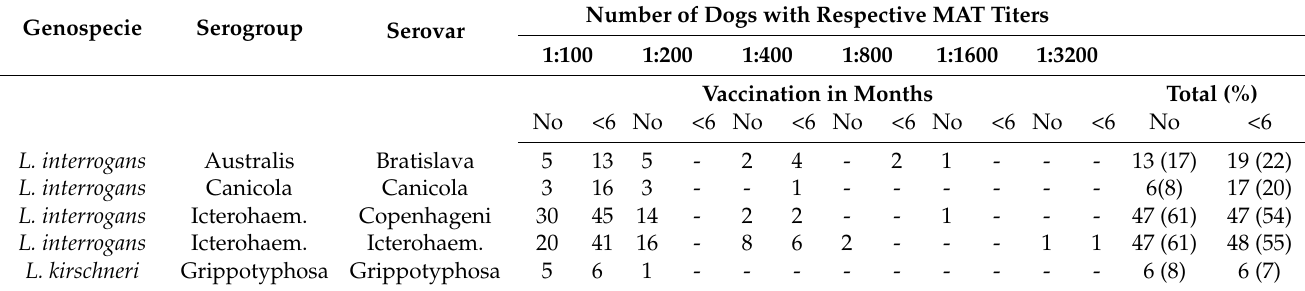
Table 5. Number of positive microscopic agglutination test (MAT) results among dogs never vaccinated and vaccinated from less than six months.